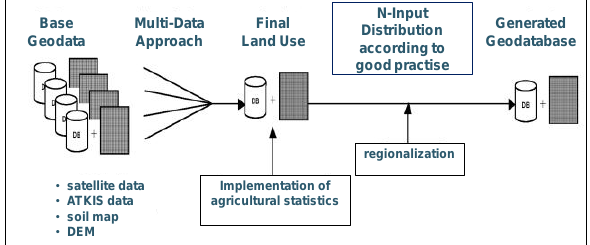
Figure 5. MDA for the “Kraichgau” (Rohierse, 2004)